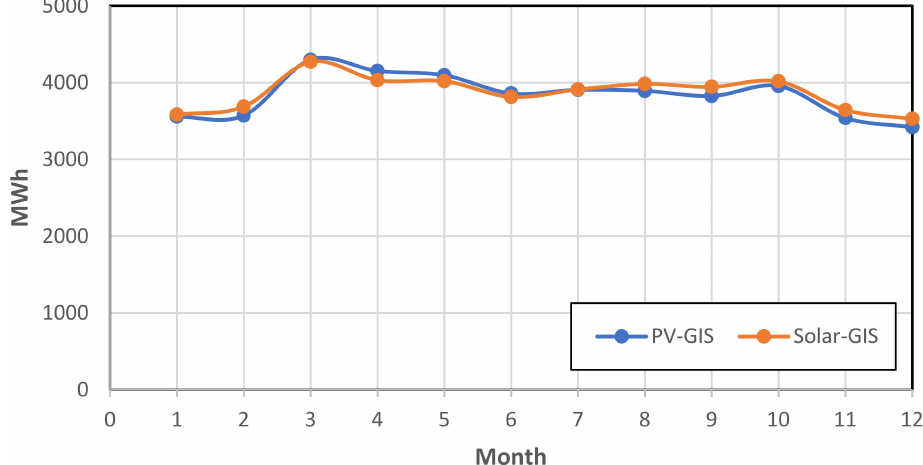
Figure 8. The comparison of monthly electricity generated from both PV-GIS and Solar-GIS programs for a 25 MW PV